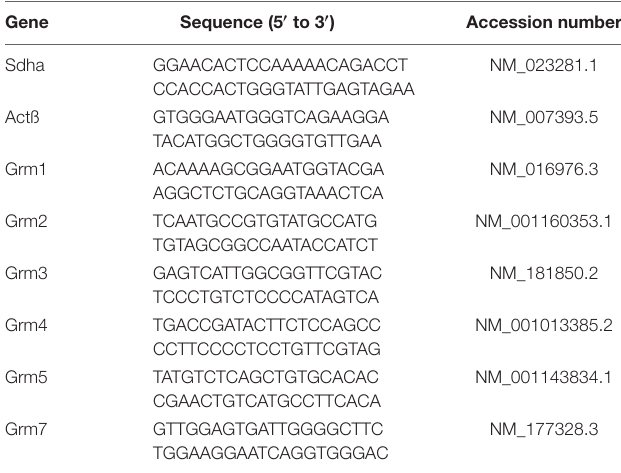
TABLE 1 | List of primers used for Reverse transcription and real-time quantitative polymerase chain reaction (RTq-PCR) analysis. Gene Sequence (5 (cid:48) to 3 (cid:48)